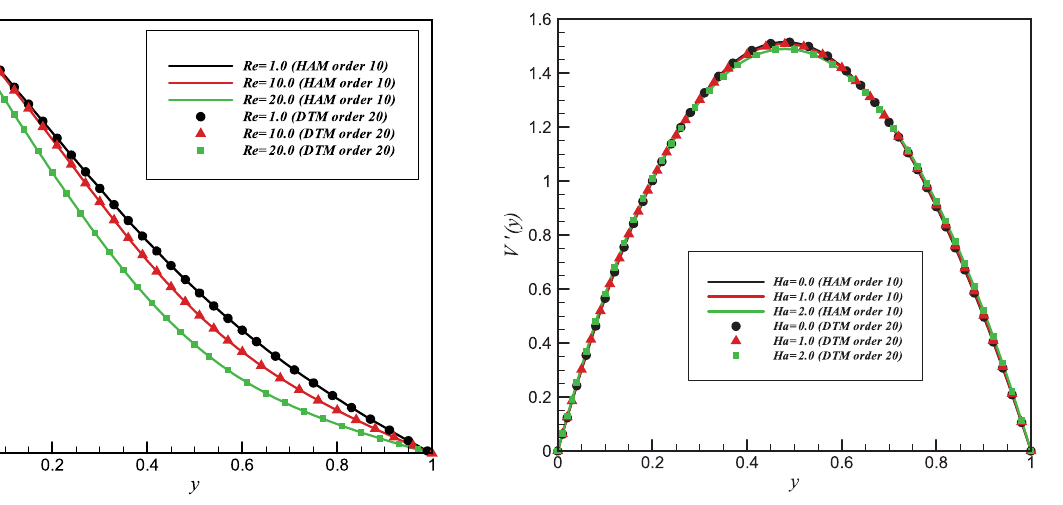
Fig. 11. The profile U ( y ) obtained by the 10th-order approximation of the HAM and 20th-order approximation of the DTM for different values of Re , when Ha = 0 . 0 , [45].